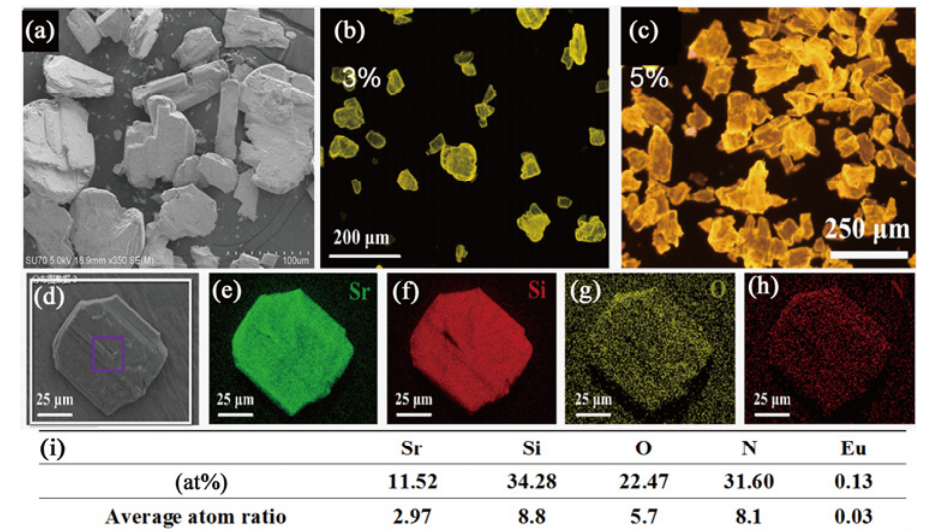
Fig. 4 Characterizations of Sr 3 − 3 x Si 8 O 4 N 10 :3 x Eu 2+ phosphor powders. (a) SEM image; (b, c) fluorescent microscopy photographs of Sr 3 − 3 x Si 8 O 4 N 10 :3 x Eu 2+ ( x = 0.03 and 0.05) under 380 nm excitation; (d–h) EDS elemental mappings of Sr, Si, O, and N; and (i) contents of each element (at%) at the selected area in (d).